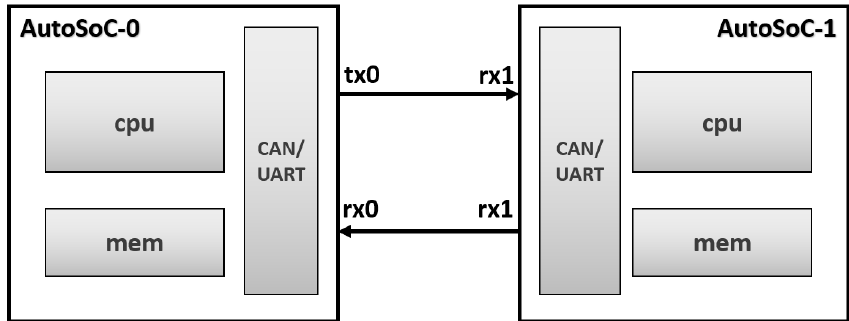
Figure 9. Experimental setup composed of two AutoSoC